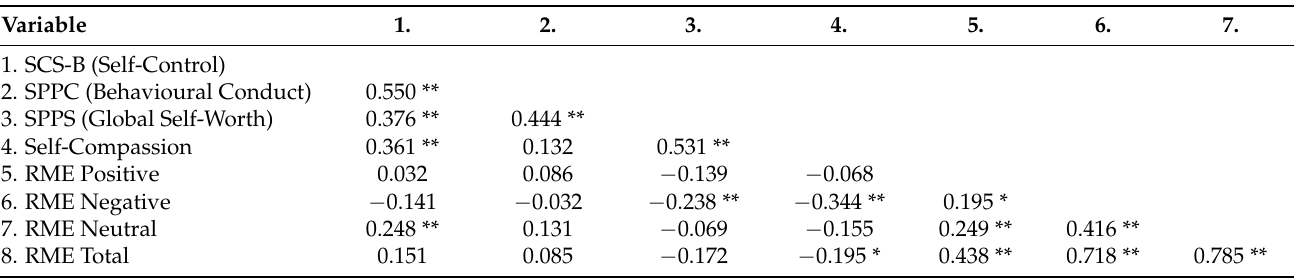
Table 2. Correlations between all